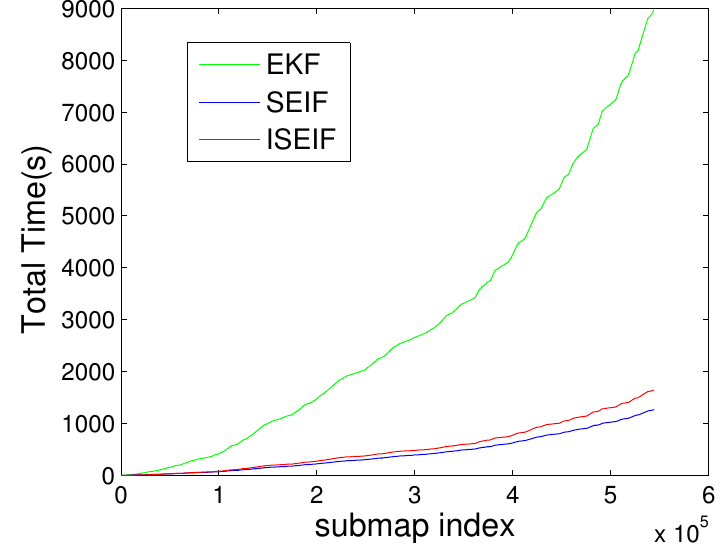
Figure 10. CPU time elapsed for the Victoria Park dataset generated by EKF, SEIF and